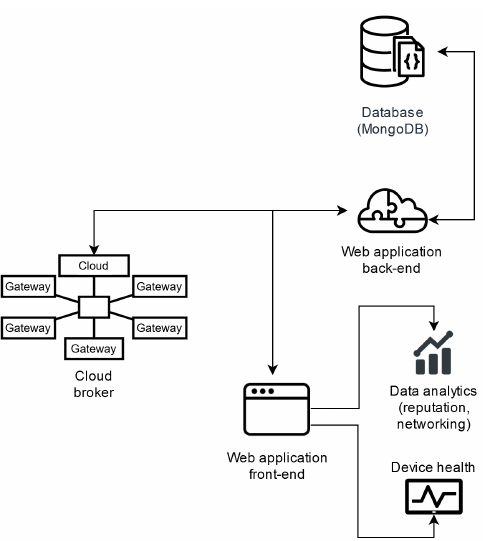
Figure 3. High-level architecture of the cloud